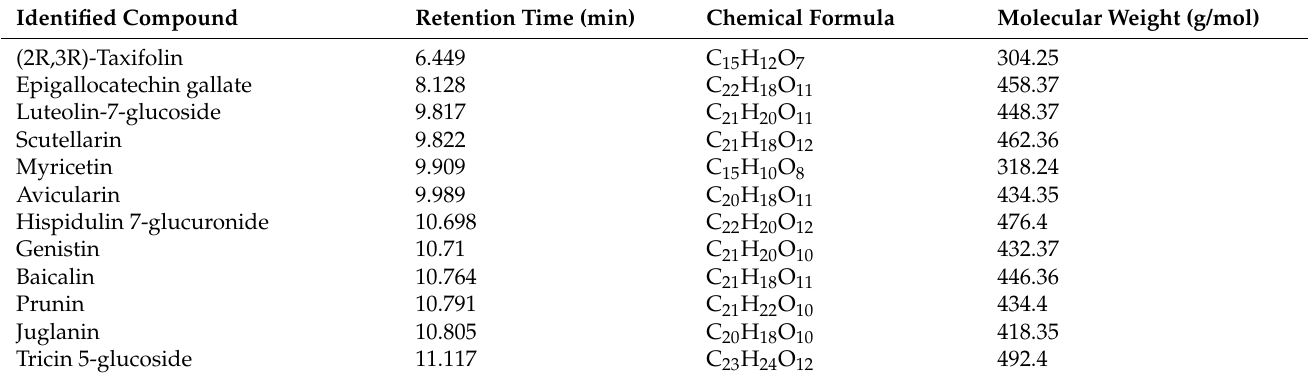
Table 2. Phytochemical profiling of aqueous K. pinnata extract using